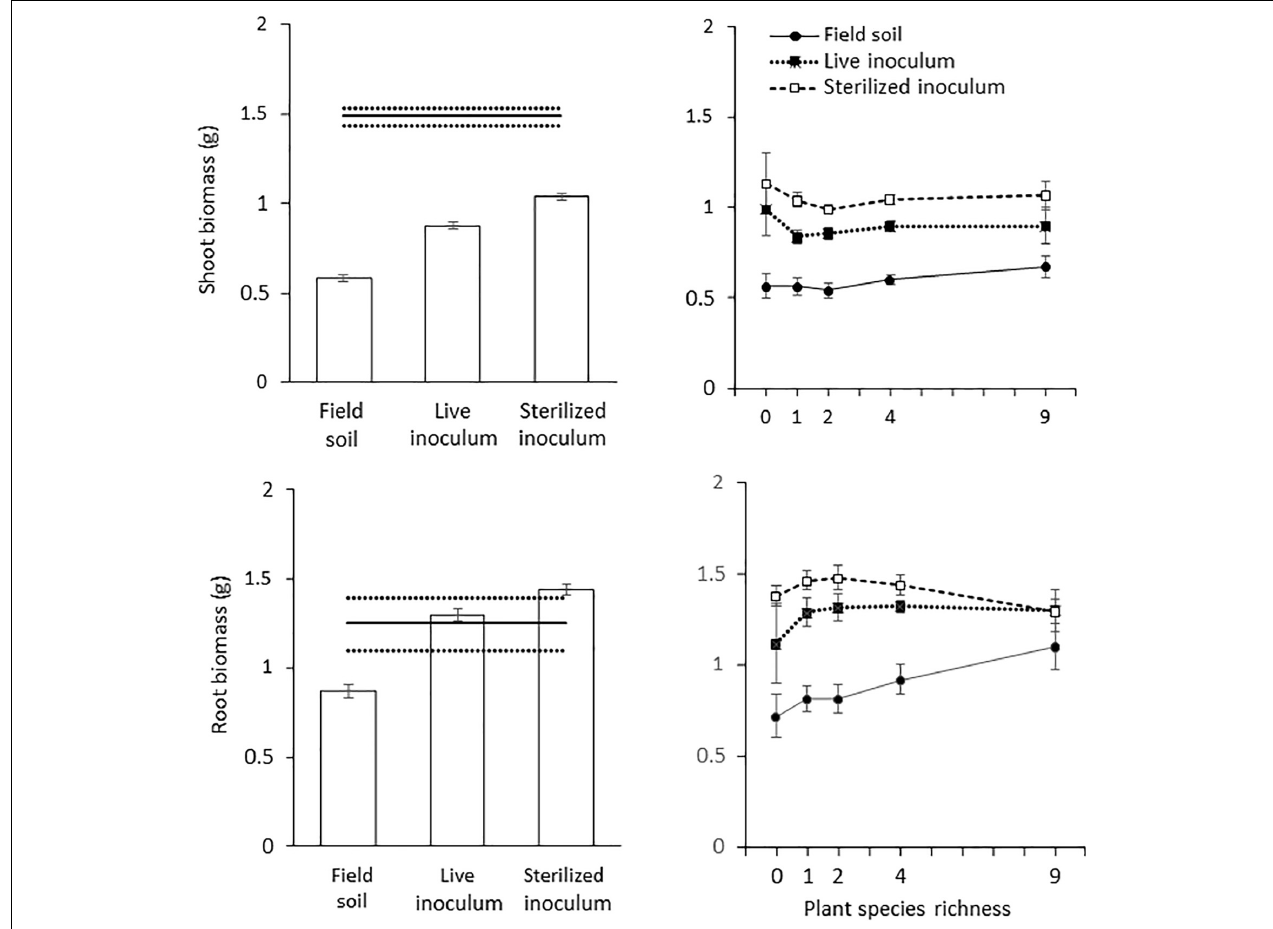
FIGURE 2 | Response of J. vulgaris to plant diversity. Shown are means ( ± SE) of all diversity levels (left panels) of shoot biomass (top panels) and root biomass (bottom panels) of J. vulgaris plants growing in pure field soil, in sterilized background soil mixed with live or sterilized inoculum; and for each diversity level (right panels). The solid black line with dashed lines represents the biomass (mean ± SE) of plants grown in sterilized background soil.